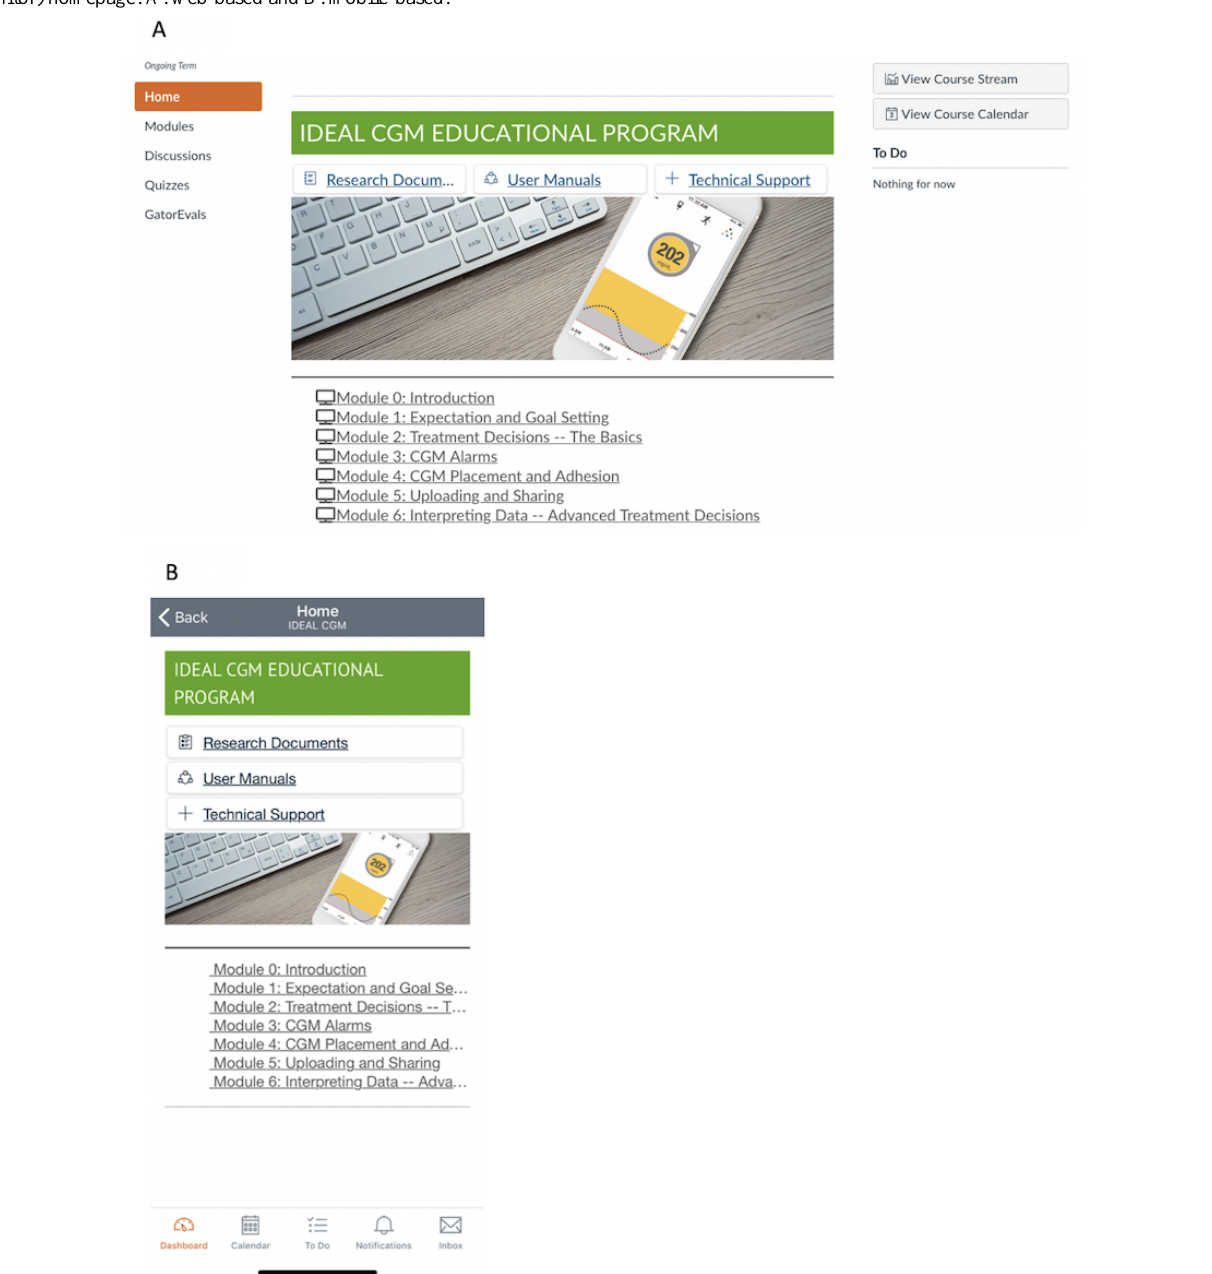
Figure 2. Screenshot of the IDEAL CGM (Intervention Designed to Educate and improve Adherence through Learning to use continuous glucose monitor) homepage. A. web-based and B.